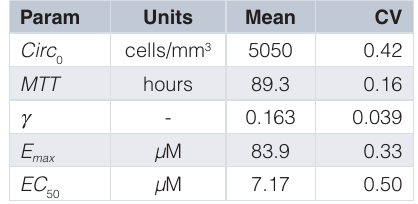
Table 2. Parameters of the chemotherapy- induced myelosuppression model of Friberg et al. [10, Table 4]. Circ neutrophil concentration; MTT : mean transit time between the 5 model compartments; γ : exponent of feedback loop; EC parameters of a model (of the standard E type) governing docetaxel-induced depletion